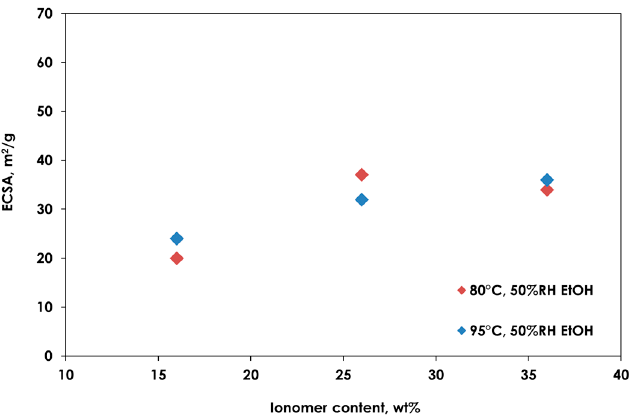
Figure 6. ECSA variation as a function of the different ionomer amounts and different operating conditions.